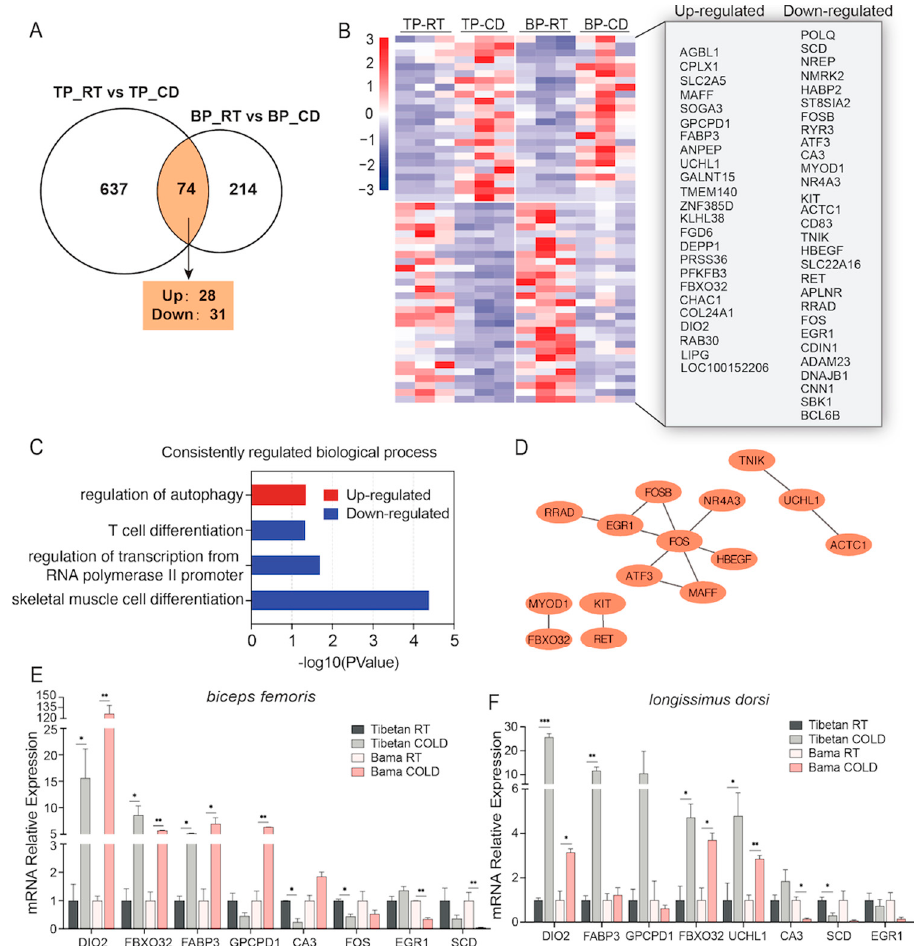
Figure 3. Functional enrichment analysis and verification of the genes commonly regulated by cold exposure in TP and BP. ( A )Venn diagram showing the number of commonly regulated DEGs between the two breeds. ( B ) Heatmap and detailed list of genes with the same expression trends. ( C ) All gene ontology (GO) terms enriched with the commonly regulated genes. ( D ) The protein-protein interaction (PPI) network of the commonly regulated genes. ( E , F ) qPCR validation of commonly regulated genes in the BF ( E ) and LDM ( F ); these genes are involved in glucose and lipid metabolism, as well as skeletal muscle cell differentiation. All values are presented as the mean ± SEM. * p < 0.05; ** p < 0.01; *** p < 0.001.